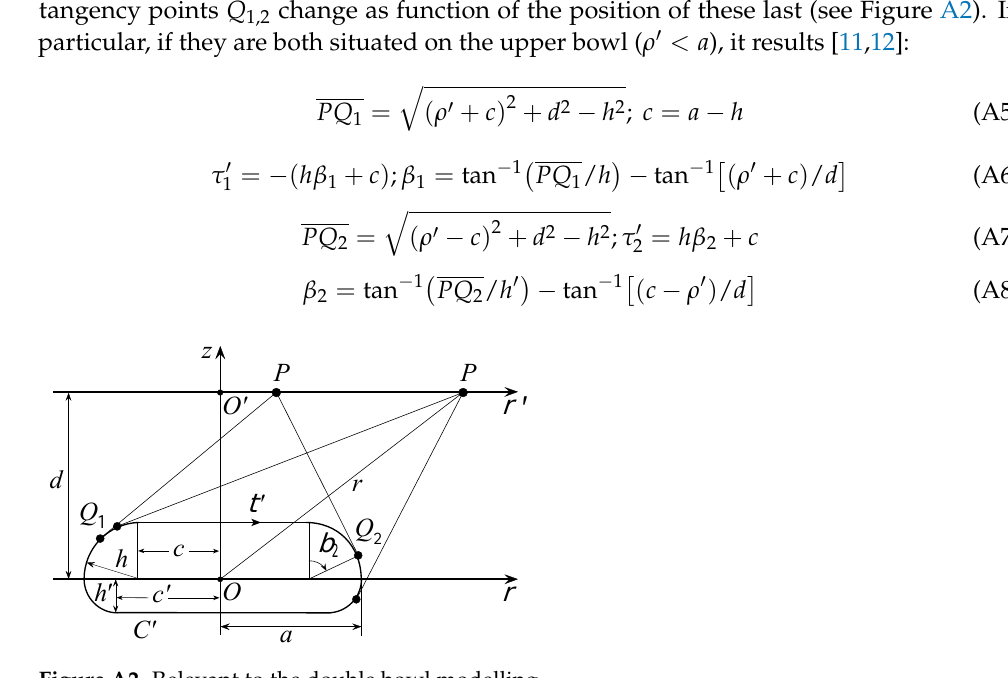
Figure A2. Relevant to the double bowl Figure B1. Relevant to the double bowl modelling.